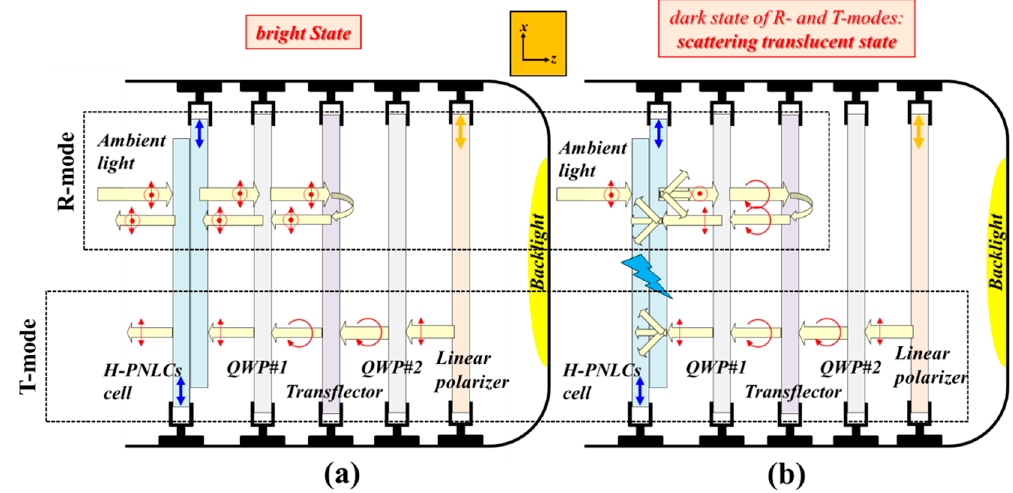
Figure 1. Schematics of a common scattering-type transflective liquid crystal displays (ST-TRLCDs) using a homogeneous polymer-network liquid crystal (H-PNLC) cell in ( a ) voltage-off bright (R- and T-modes) states and ( b ) voltage-on scattering-translucent (R- and T-modes) states [4]. QWP represents a quarter-wave plate. The “light blue thunder” symbol represents that the H-PNLC cell is being applied with a suitable electric field. Blue arrows plotted in H-PNLC cells and orange arrows plotted in linear polarizers represent the rubbing directions of the two substrates of an H-PNLC cell and the transmissive axes of linear polarizers, respectively; red arrows and dots represent the polarization states of linearly polarized light (LPL); circular arrows represent circularly polarized light.